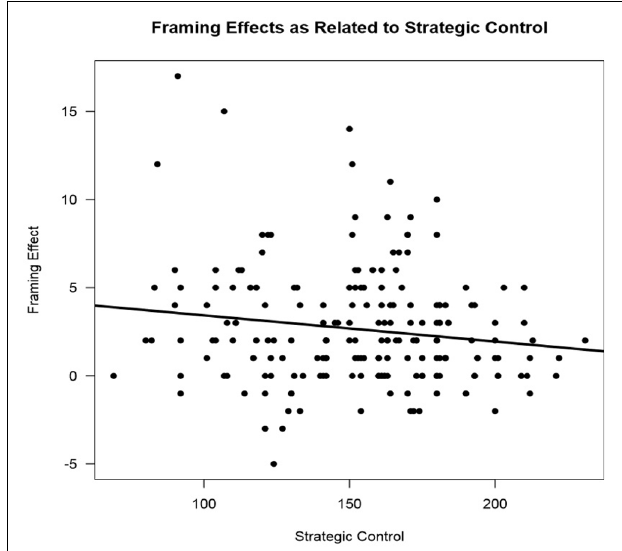
FIGURE 5 | The influence of strategic control on framing effects. A scatter plot of scores on a measure of strategic control and framing effects. The amount deviation from 0 in framing effects represents the amount of susceptibility to framing bias. The solid line represents the influence of strategic control on framing effects [ F (1,193) = 432, p = 0.04] which was significant.